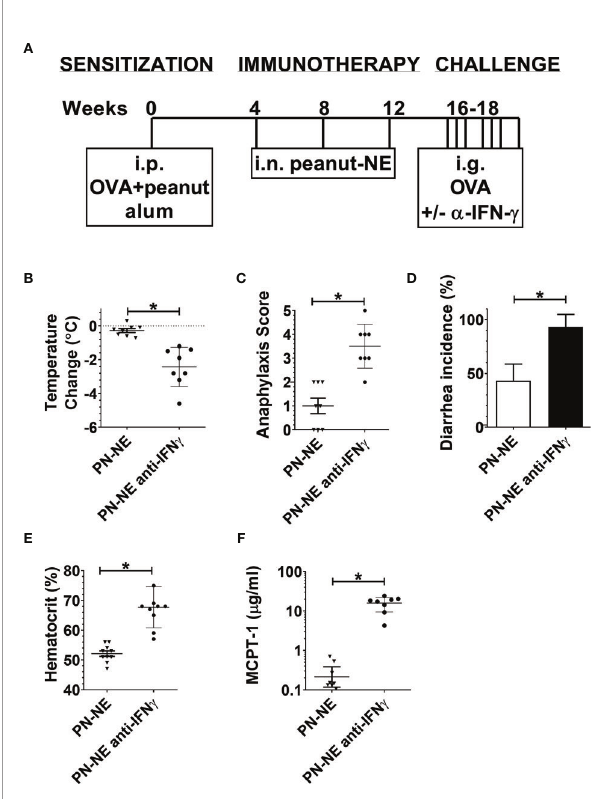
FIGURE 5 | Bystander protection induced by NE allergy vaccines requires IFN- g (A) Mice were sensitized with OVA and peanut-alum and treated i.n. with 3 administrations of PBS (sensitized control) or peanut-NE (PN-NE). Mice were challenged orally with OVA and IFN- g was depleted during the challenge phase. (B) Temperature change, (C) symptoms of anaphylaxis and (D) diarrhea were monitored. (E) Hemoconcentration was determined by hematocrit. (F) Levels of MCPT-1 in the serum 60 min after challenge were determined by ELISA. Statistically signi fi cant differences (p < 0.05) are indicated by